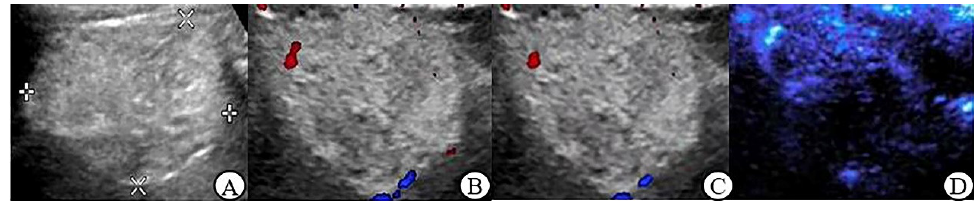
Figure 3. Angiomyolipoma (largest diameter 5.7 cm) ( A ): Gray scale ultrasound: the mass with clear boundary, hyperechoic, and the internal echogenicity was heterogeneous; ( B ): CDFI: 3 dotted blood flow signal was observed in the lesion, Adler Grade 2; ( C ): PDI: 2 dotted blood flow signal was observed in the lesion, Adler Grade 1; ( D ): MFI: dotted and linear blood flow signal was observed in the lesion, Adler Grade 2, there is no annulus blood flow.